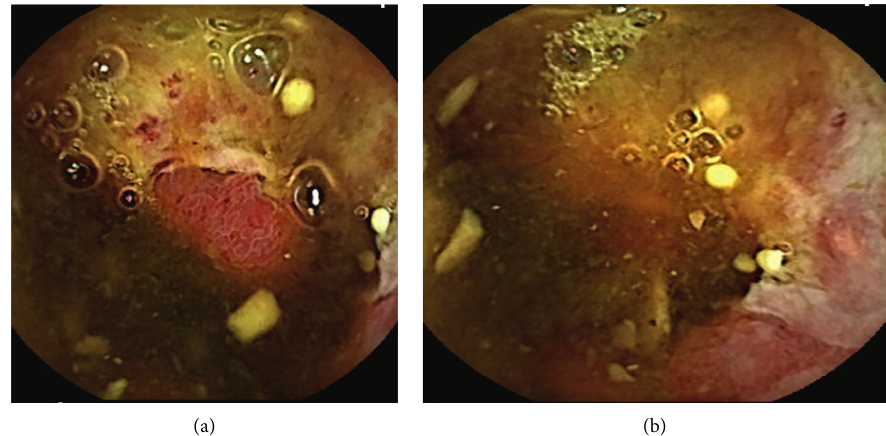
Figure 2: (a) Capsule endoscopy image of erythematous, ulcerated, and congested area of mucosa presumed to be localized to the distal ileum at 6 hours, 26 minutes, and 12 seconds. (b) Additional image of the aforementioned area located in distal ileum on capsule endoscopy.